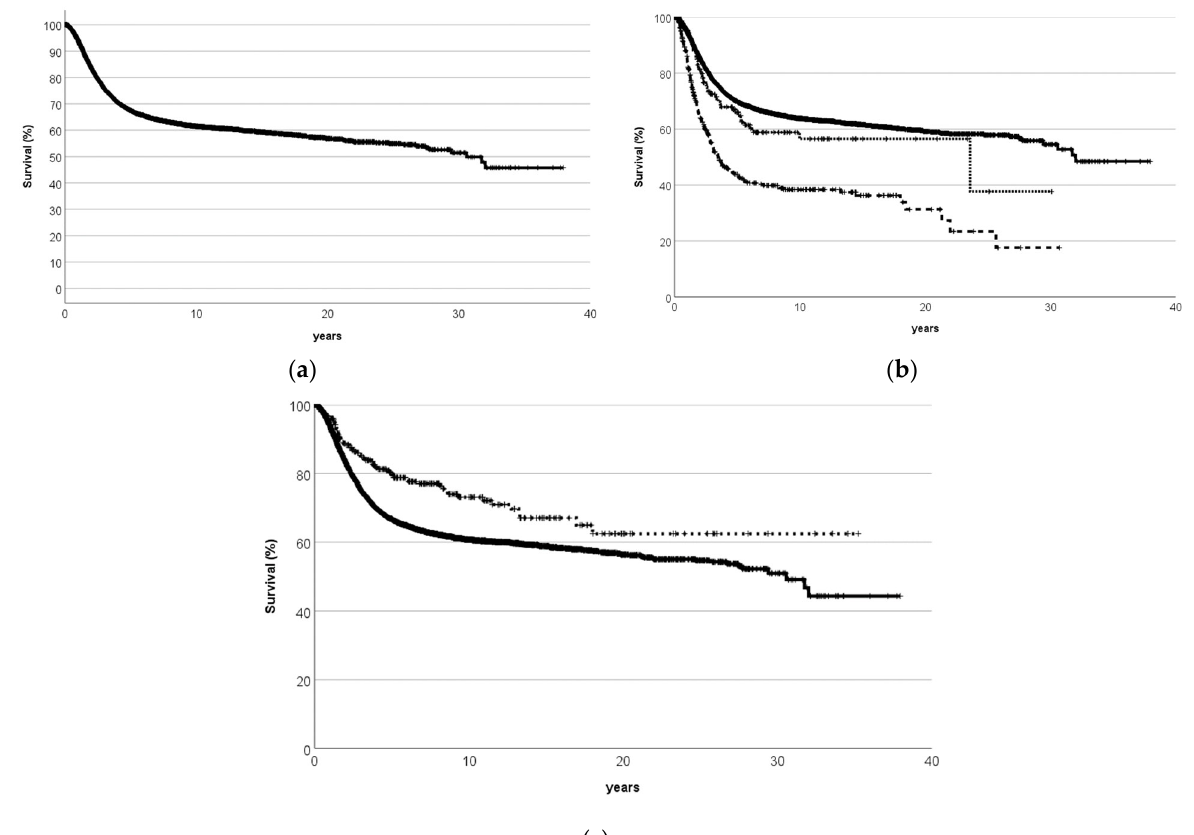
Figure 2. Survival probability of previously untreated Cooperative Osteosarcoma Study Group patients with osteosarcomas 1980–2001. Patients registered >1 year after biopsy excluded. Median follow ‐ up 5.04 (0.003—37.96) years from diagnostic biopsy. ( a )—all 4657 patients. ( b )—by primary tumor site: limb ( n = 4071, solid line) vs. trunk ( n = 404, dashed line) vs. head and neck ( n = 177, dotted line); 5 primary sites unknown. Osteosarcomas of the trunk had an inferior survival probability to either those of the extremities or the head and neck ( p < 0.001, log ‐ rank test, respectively). ( c )—by grade of malignancy: high ‐ grade central ( n = 4136, solid line) vs. others ( n = 337, dashed line); head and neck osteosarcomas excluded; 8 grades not documented ( p < 0.001, log ‐ rank test).